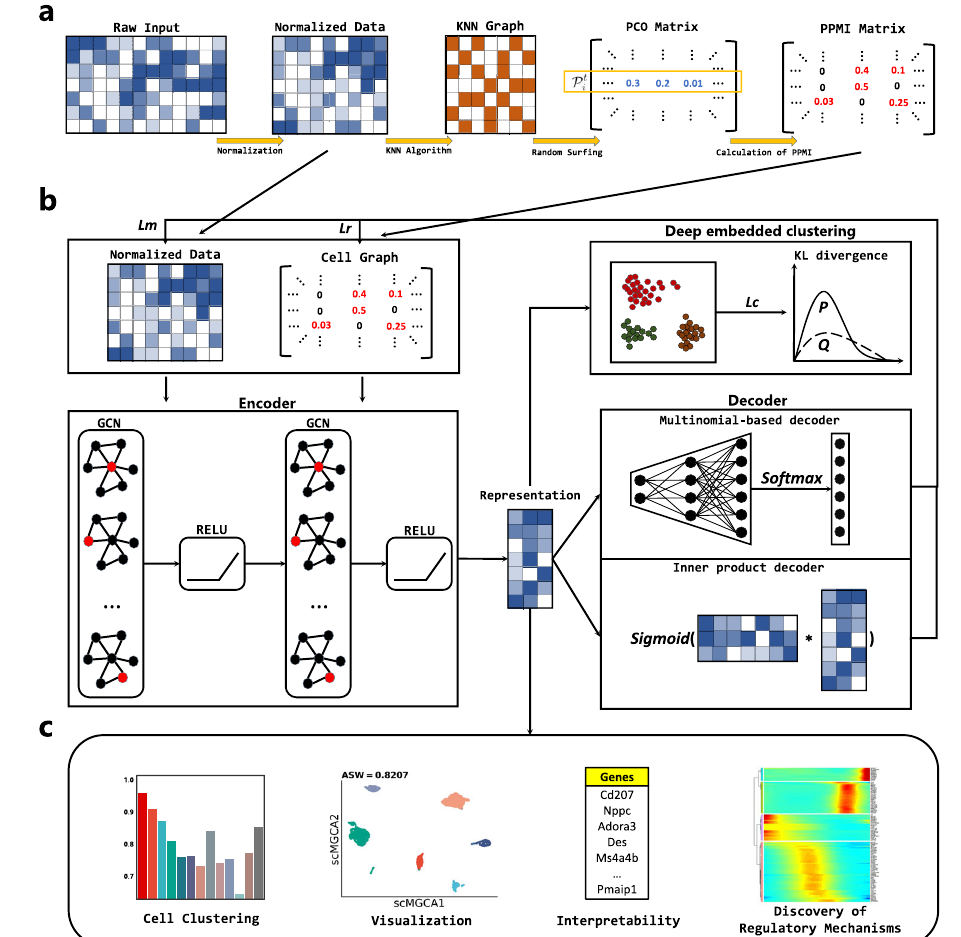
Fig. 1 | The network architecture of the scMGCA algorithm. a The construction process of the cell-PPMI graph. b The work fl ow of scMGCA. c Functional genomics application capabilities of latent embedded representations trained by